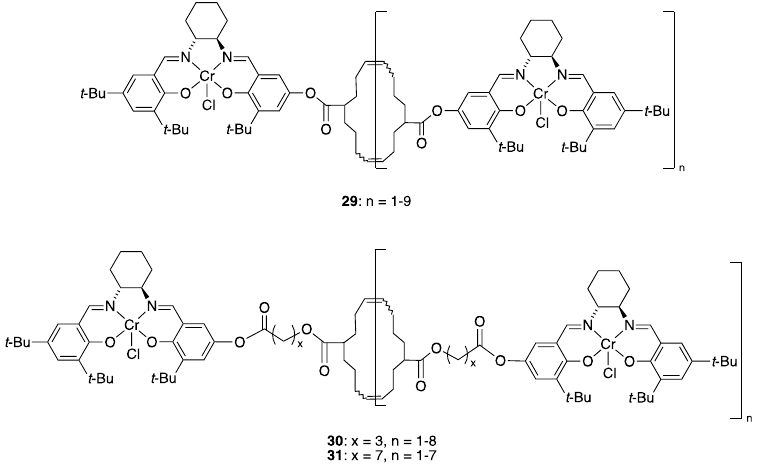
Figure 10. Macrocyclic oligomer-supported Cr–salen catalysts.